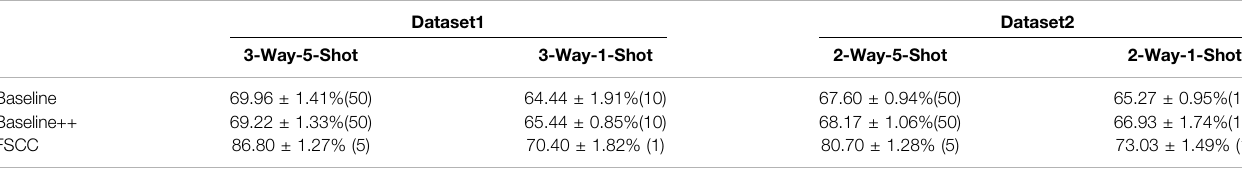
TABLE 5 | Classi fi cation performance of FSCC on real datasets. The classi fi cation performance is measured by classi fi cation accuracy, followed by the number of labeled training macromolecules in